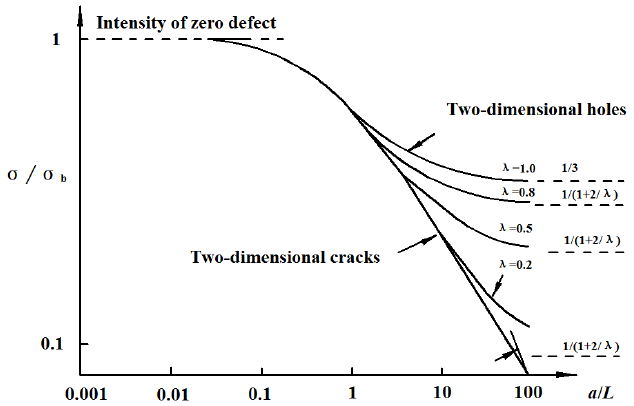
Figure 11. Influence of defect on failure stress.